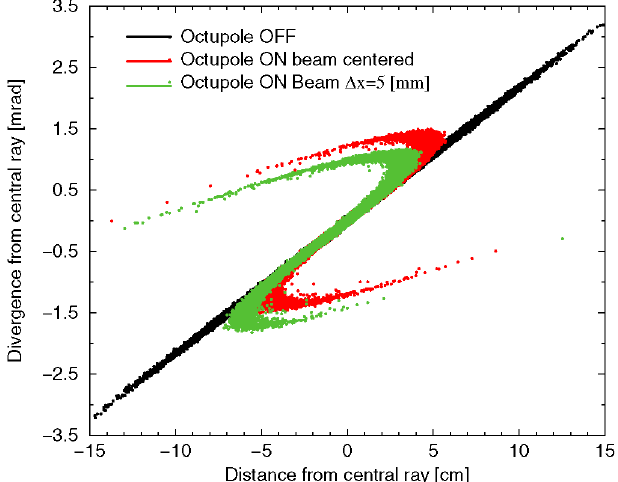
FIG. 9. (Color) Computer simulations of horizontal beam pro- files on the target for three different cases (see text). The parallel displacement of the octupole’s axis from the center of the beam generates the ‘‘slanted’’ beam distribution (green dotted line) on the